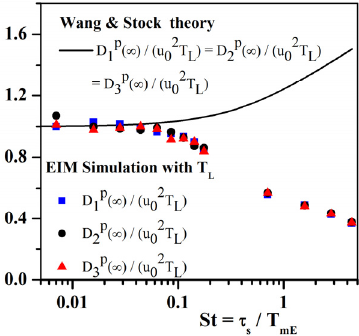
Figure 5. Normalized variance of particle velocity (g = 0).